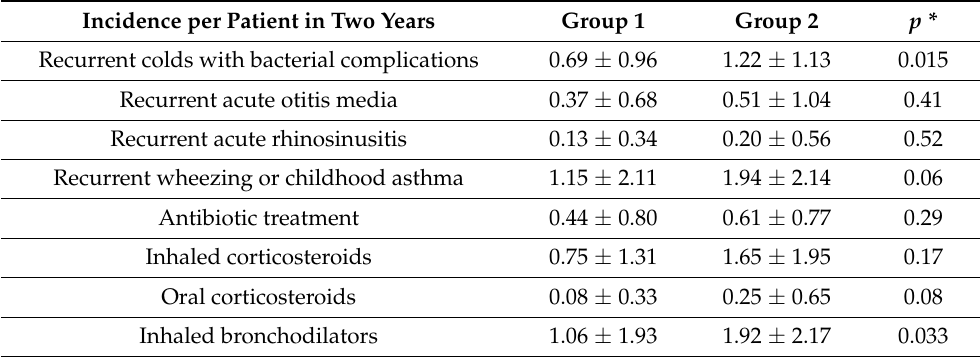
Table 5. Mean number of acute episodes and treatment in children less than two years of age for infectious diseases and childhood asthma in the two cohorts of healthy children. Incidence per Patient in Two